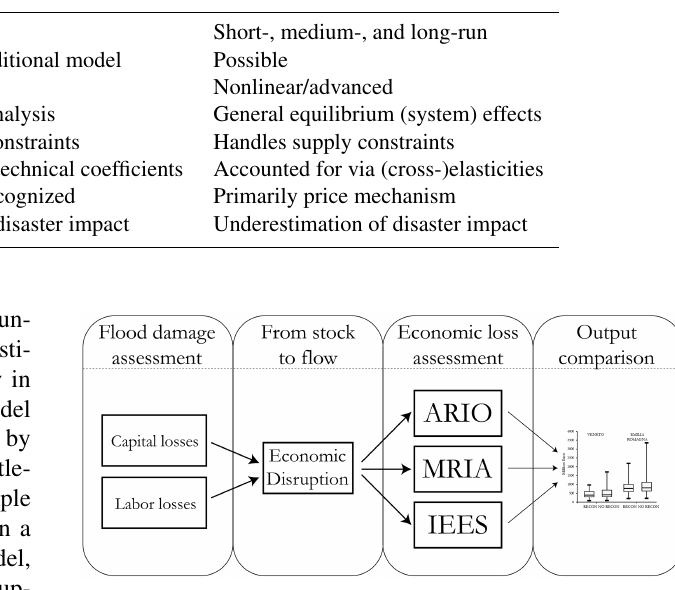
Table 1. Comparison of IO and CGE approach on important modelling characteristics. Characteristic IO CGE Time horizon Short-run Short-, medium-, and long-run Not possible in traditional model Possible